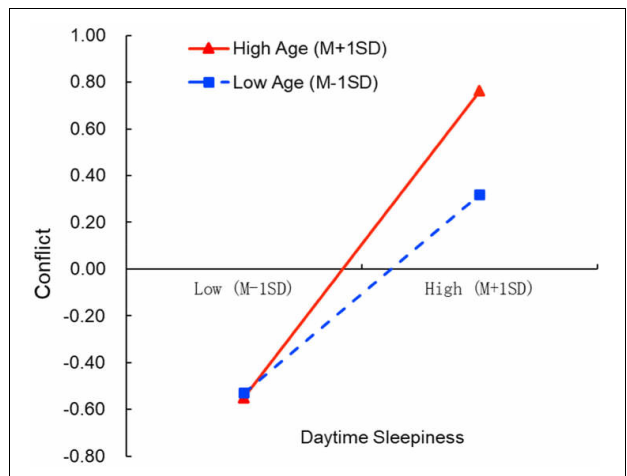
FIGURE 3 | Age moderated the relationship between daytime sleepiness and